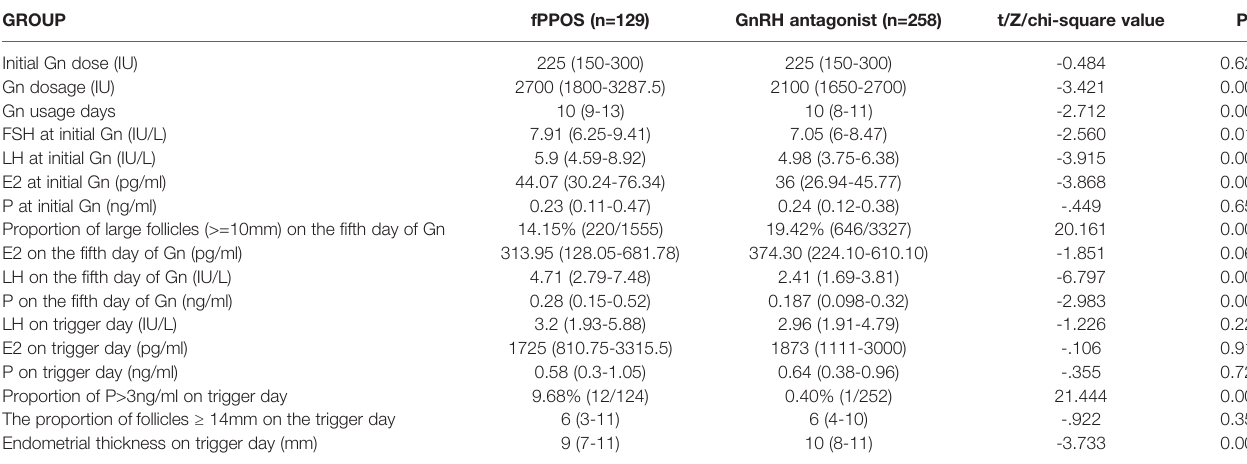
TABLE 2 | Data during controlled ovarian stimulation in the two groups. GROUP